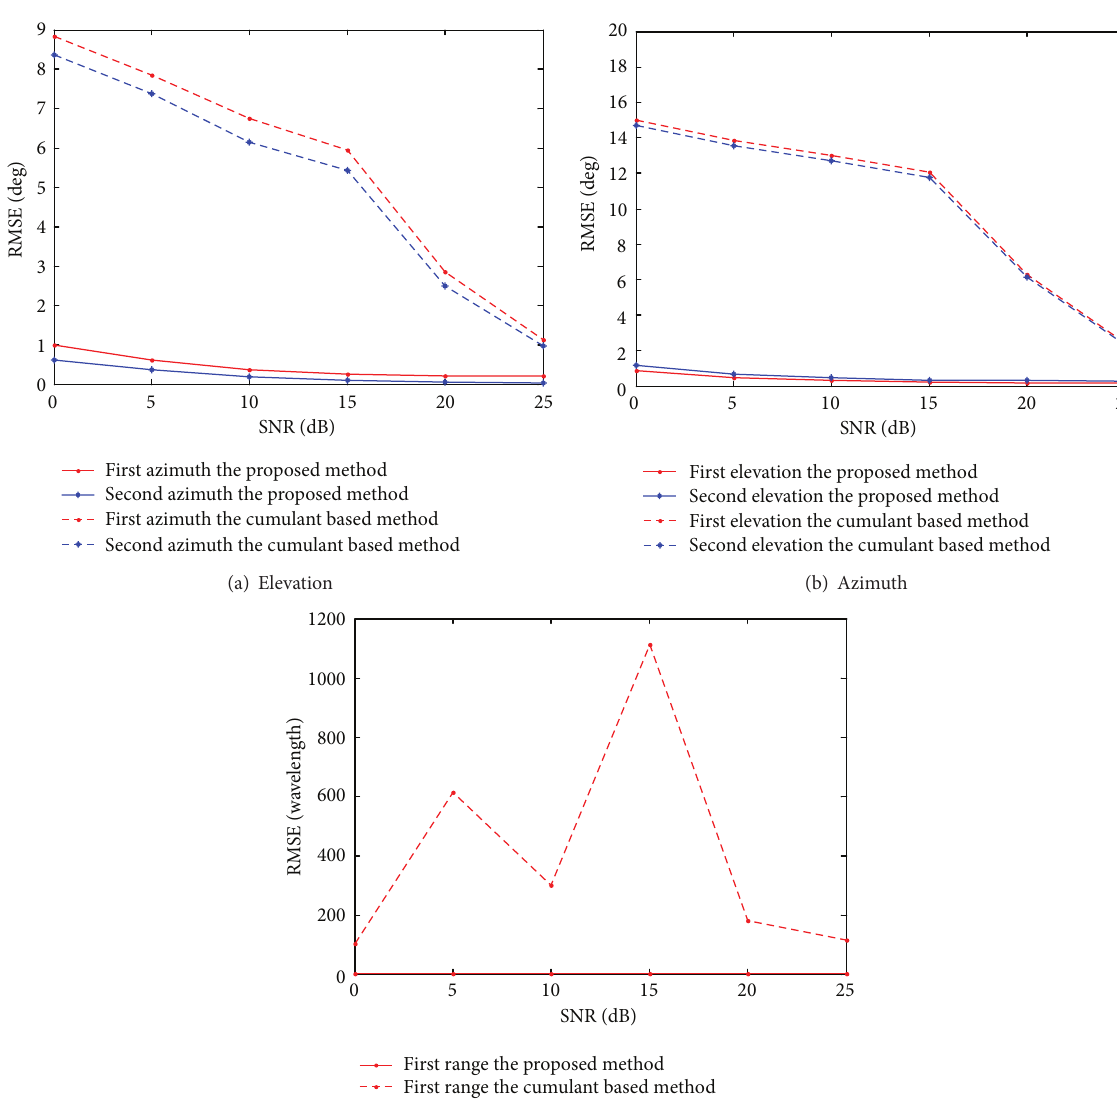
Figure 3: The RMSEs of the elevation, azimuth, and range estimation using the proposed method and the fourth-order cumulant based method versus